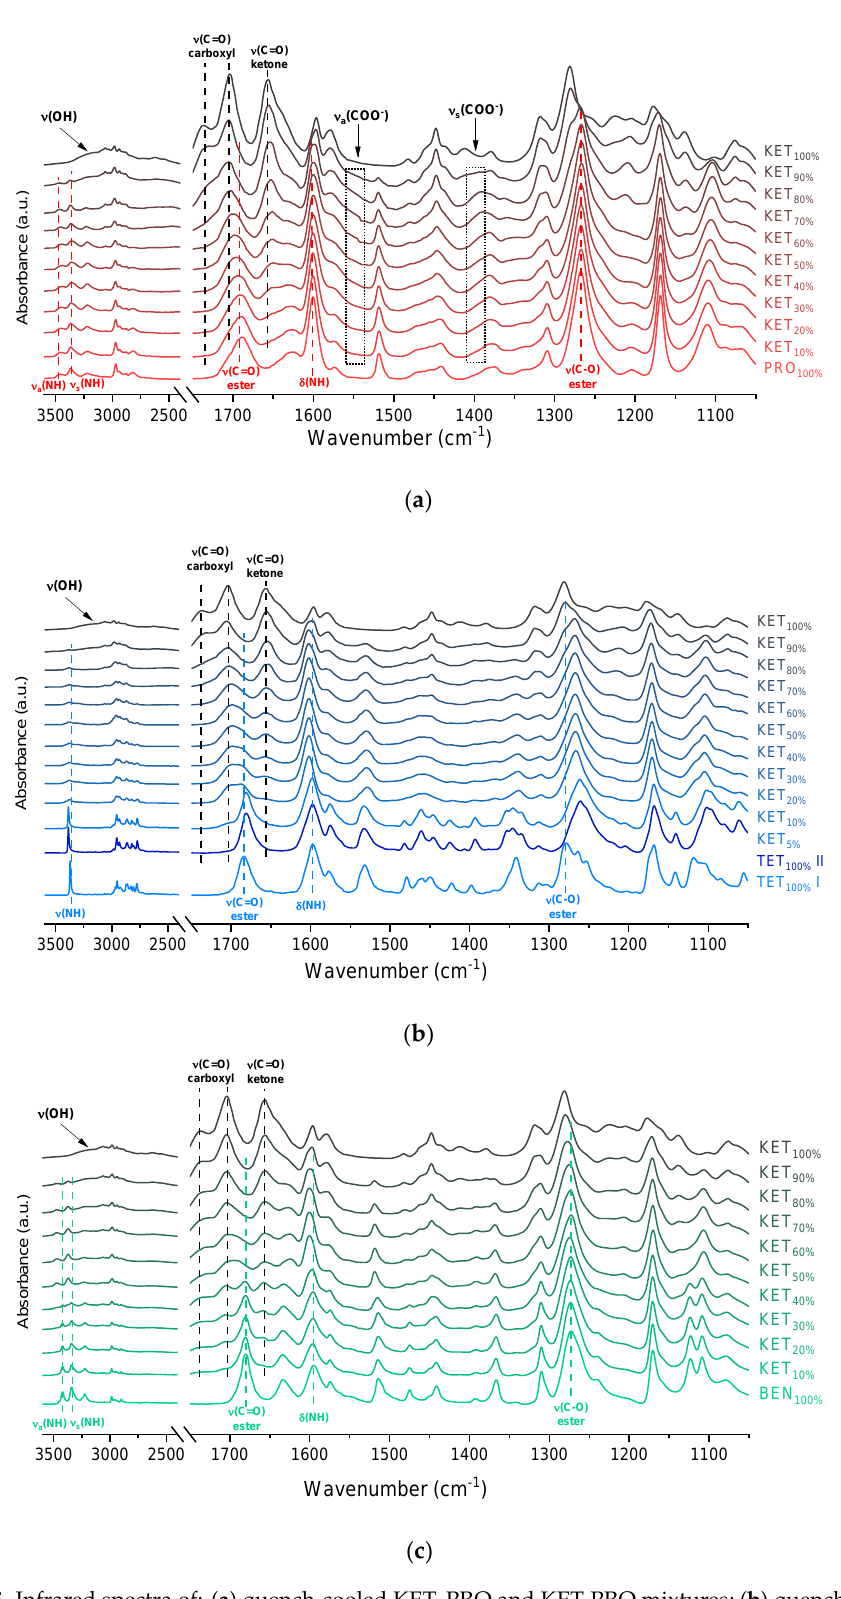
Figure 5. Infrared spectra of: ( a ) quench-cooled KET, PRO and KET-PRO mixtures; ( b ) quench-cooled KET, TET I, TET II and KET-PRO mixtures and ( c ) quench-cooled KET, BEN and KET-BEN mixtures. ν —stretching, ν ν ∆ —bending vibrations. ν — stretching, ν a — asymmetric stretching, ν s — symmetric stretching and Δ— bending vibrations. The a —asymmetric stretching, s —symmetric stretching and subscript indicates the content of the named component in mole%. The subscript indicates the content of the named component in